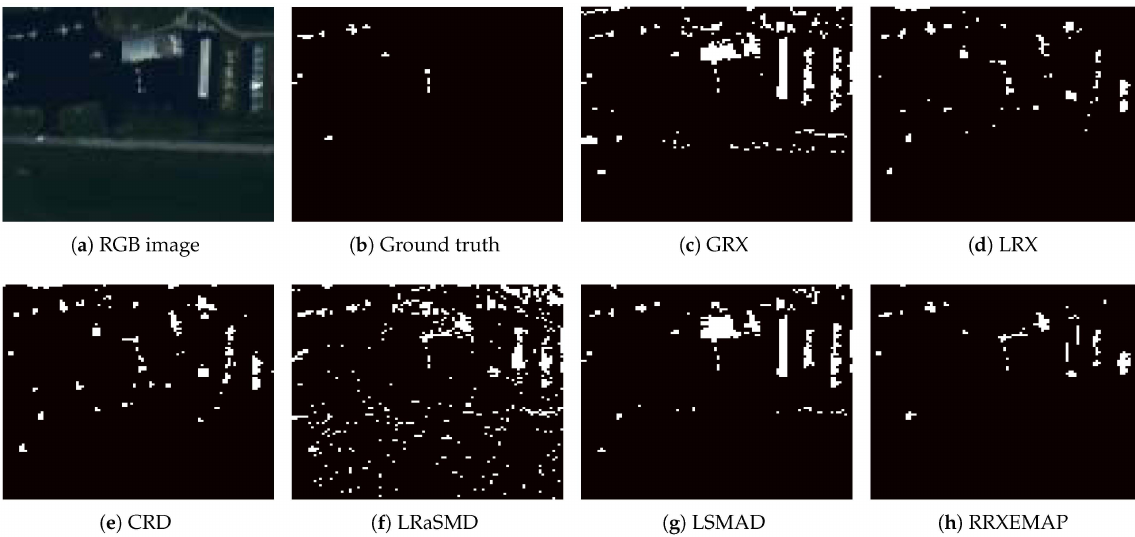
Figure 16. Color detection maps obtained by different algorithms for the abu-urban-3